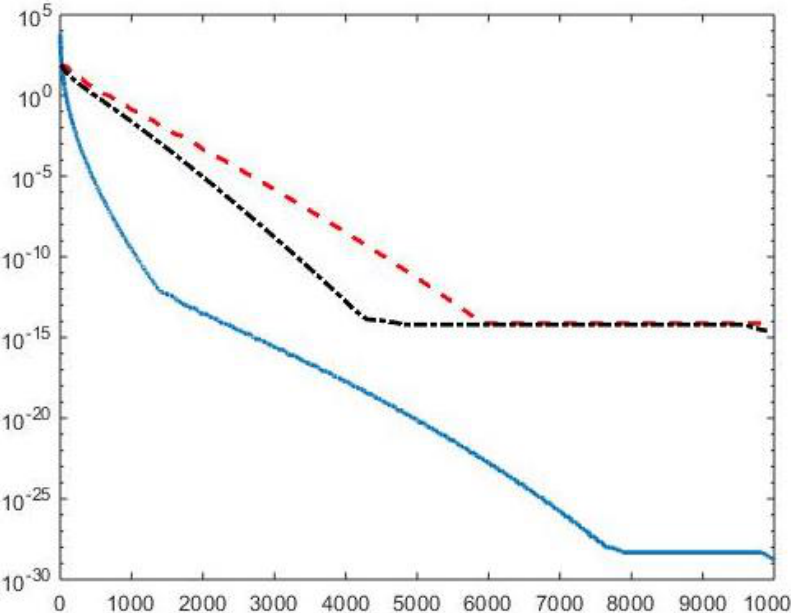
Figure 3. The singular values of K (blue line), K 1 (red dashed line) and K 2 (black dashdotted line). For easier visualization, the singular values of K 1 and K 2 are plotted versus the integers 1,100 1 ,100 2 , . . . ,100 100